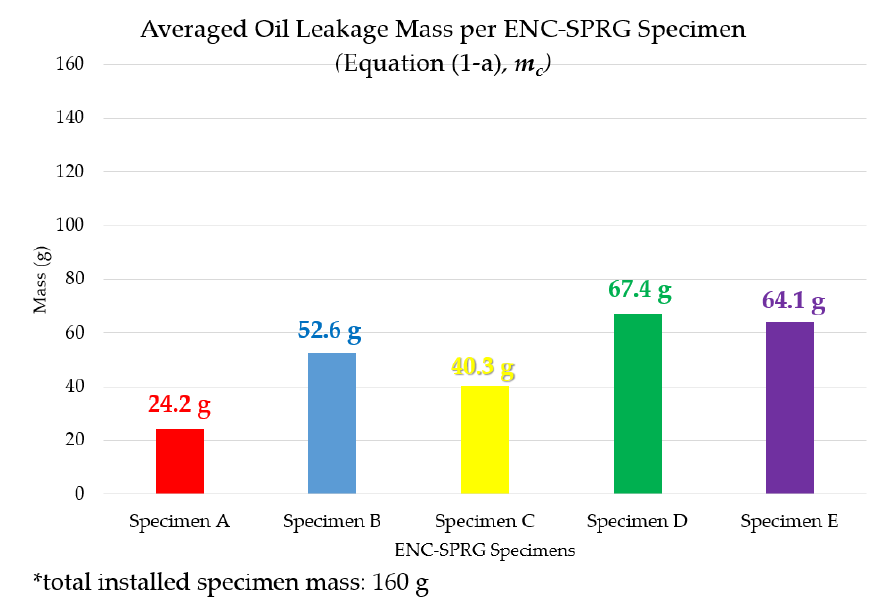
Figure 8. Averaged mass of the sums of leaked oil. Materials 2019 , 12 , x FOR PEER REVIEW